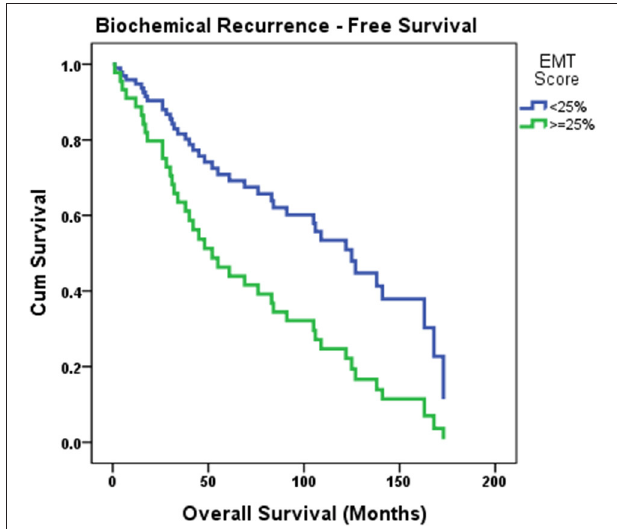
FIGURE 3 | Biochemical recurrence-free survival curve estimating PSA failure based on the patients’ EMT score. Cox regression model was built where time to PSA failure was considered time to event, and EMT score, Gleason group, pathological stage and surgical margins were added as covariates to the model. Biochemical recurrence was found to be higher in patients with EMT score ≥ 25% ( p =